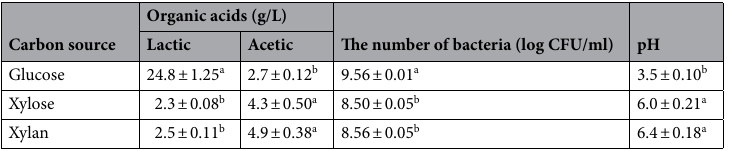
Table 1. Parameters determined in the medium after Lactobacillus buchneri M B/00077 incubation depending on the carbon source. a,b Mean values (in rows) marked with different letters differ significantly, α = 0.05.